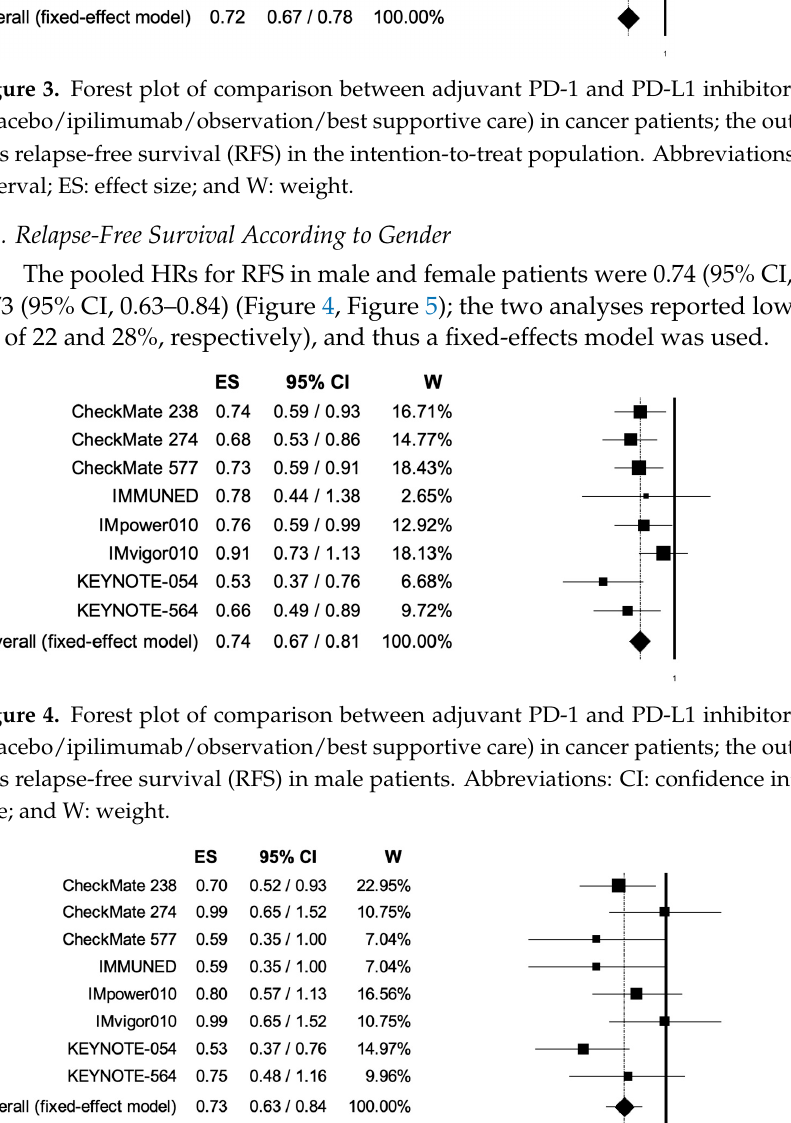
Figure 6. Forest plot of comparison between adjuvant PD-1 and PD-L1 inhibitors versus control (placebo/ipilimumab/observation/best supportive care) in cancer patients; the outcome of interest